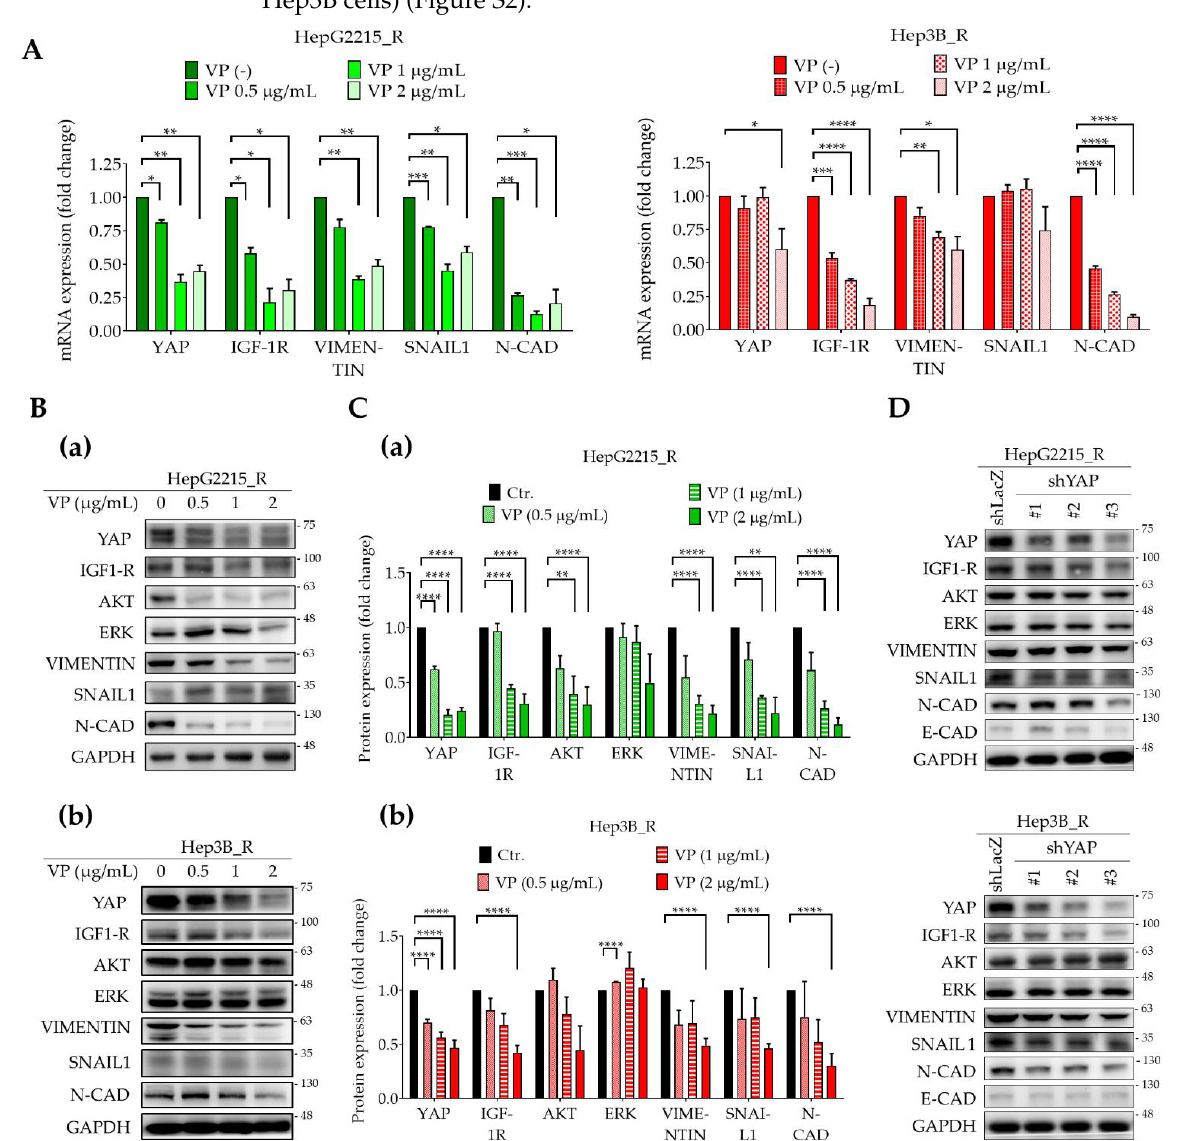
Figure 3. YAP regulates IGF-1R signaling-related proteins and EMT markers in sorafenib-resistant HCCs. ( A – C ) Effect of VP (a specific YAP inhibitor) on the expression levels of ( A ) mRNA and ( B ) protein of YAP, IGF-1R signaling-related proteins, and EMT markers in sorafenib-resistant HepG2215-R cells and Hep3B-R cells. ( C ) The quantitative data of ( B ). ( D ) Effect of YAP silencing by shRNA on the protein levels of YAP, IGF-1R-related signaling proteins, and EMT markers in HepG2215-R cells and Hep3B-R cells. For all quantification, data are the mean ± SEM of at least three independent experiments. * p < 0.05, ** p < 0.01, *** p < 0.001, and **** p < 0.0001 by Student’s t -test.